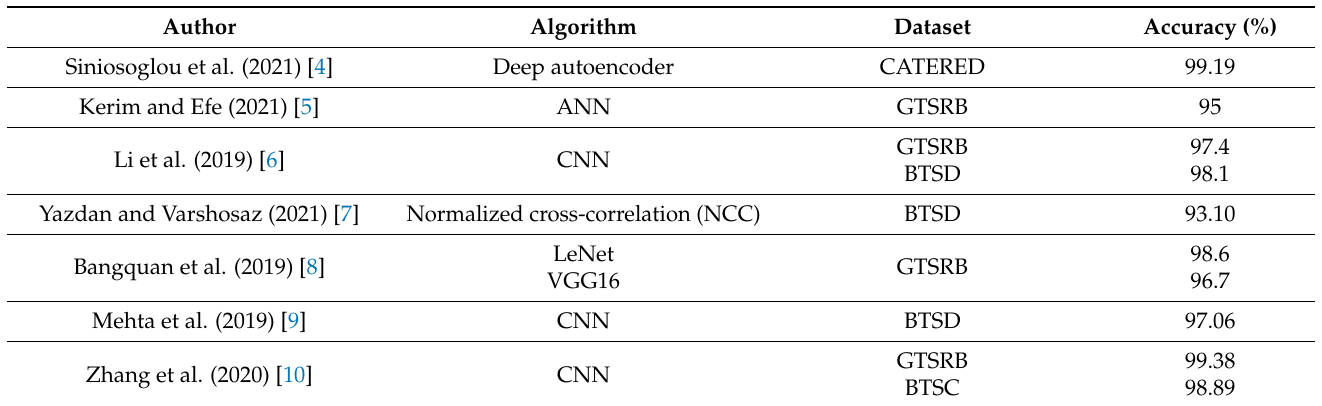
Table 1. Summary of the existing literature on traffic sign